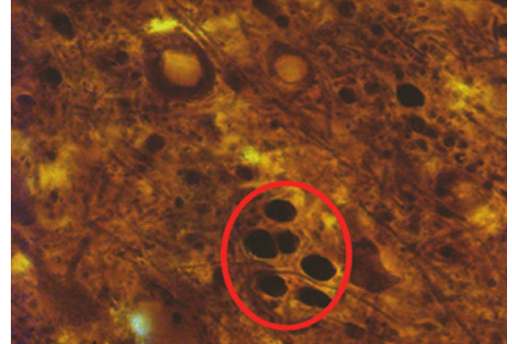
m vibratome cut section demonstrates vertical minicolumnar organization in the human inferior frontal cortex via immunohistochemistry section incubated with primary antibodies to microtubule-associated protein type 2 (MAP2) that labels apical dendrites (Figure 1; 1000x; red circle). Note the radial organization of columnar components in this tangential section through layer IV. is represents the center of a cortical